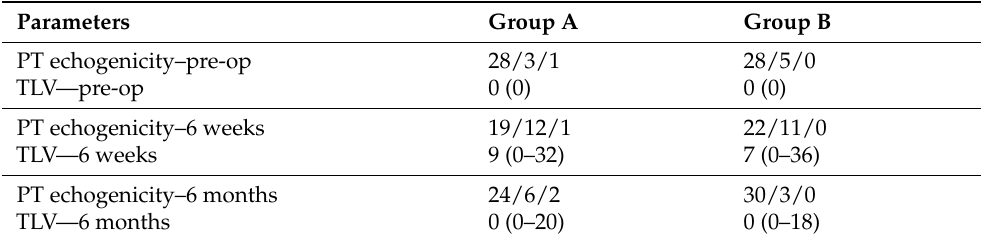
Table 5. Echogenicity and vasculature of PTs. The echogenicity is presented as nor- mal/decreased/increased; Median TLV values are presented with min-max values in